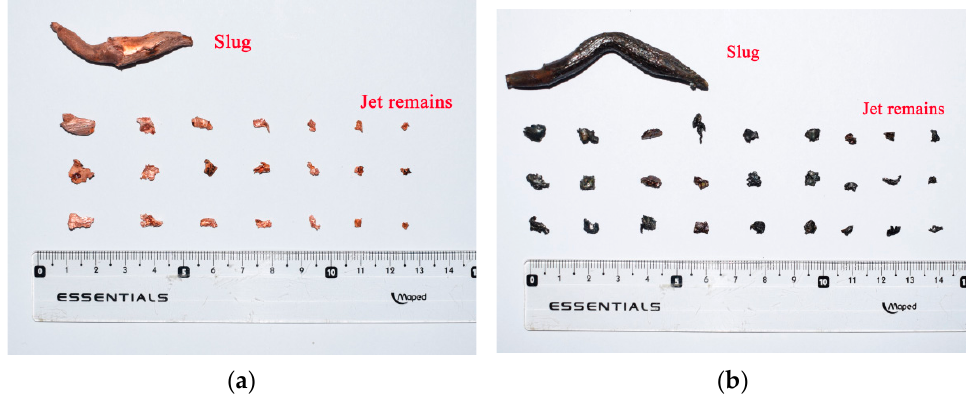
( b ) Figure 10. Temperature distribution of the OFHC-Cu and Mo jets (at 40 µs). ( a ) Theoretical predictions; ( b ) Numerical simulations. Table 4. Temperature distribution of the jets at 40 µs and data comparison. Material Average Temperature (K) Numerical